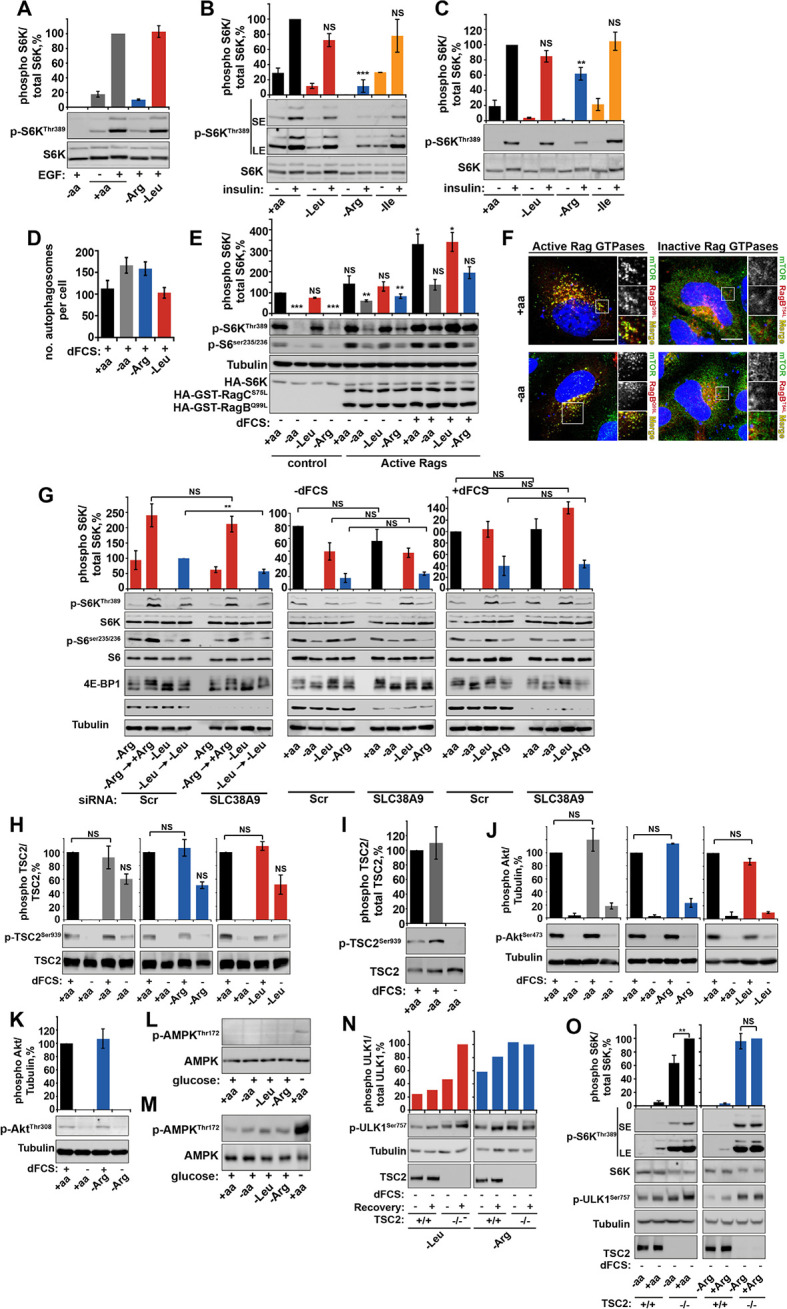
Arginine contributes to mTORC1 activity via TSC2/Rheb signaling axis.(A–C) Arginine deprivation specifically perturbs growth factor-mediated mTORC1 activity. HeLa cells (A, B) and wild-type MEFs (C) were incubated with either a complete amino acid mixture or starved of individual amino acids as indicated, in the presence or absence of EGF (100 ng/ml) (A) or insulin (10 μg/ml) (B, C). Lysates were subjected to immunoblotting for phosphorylation of S6K. (D) Arginine starvation activates autophagy. HeLa cells were pre-treated with chloroquine for 3 hr prior to being starved of the indicated amino acid (in the presence of dFCS) for 1 hr. Cells were fixed and stained with antibodies against LC3. The number of autophagosomes per cell was quantified. (E–G) Perturbation of growth factor signaling by arginine starvation is not dependent on SLC38A9/Rag GTPase protein complexes. HeLa cells were transfected with constitutive active heterodimer of RagB (Q99L), RagC (S75L), and HA-tagged S6K and deprived of amino acids as indicated, either in the presence or in the absence of dFCS. Lysates were analyzed by immunoblot for phosphorylation of S6K (E). (F) HeLa cells were transfected with active or inactive Rag GTPases and incubated in the presence or absence of amino acids. Cells were fixed and stained with antibodies against mTOR and V5 or HA-tagged Rag GTPases to confirm their localization and effect on mTOR localization. (G) HeLa cells were subjected to siRNA against SLC38A9 (100 nM) or scramble control (Scr) for 96 hr. Cells were then analyzed for mTORC1 activity in cells; first, cells were starved and recovered with either arginine or leucine or starved either in the presence or absence of dFCS. Cell lysates were analyzed for phospho-S6K, phospho-S6 and 4E-BP1 and SLC38A9. HeLa cells (H) and wild-type MEFs (I) were incubated with amino acid and dFCS mixtures as indicated. Lysates were analyzed for phosphorylation of TSC2 at serine 939. Of note, there is some increased phosphorylation in cells completely starved of amino acids, arginine and leucine. It has been noted previously that amino acid deprivation can contribute to feed-back mechanisms that involve IRS1 and re-activation of Akt (see review [Manning, 2004]). As there was no specificity to arginine starvation, this observation was not explored further. HeLa cells (J, K) were incubated with amino acid and dFCS mixtures as indicated. Lysates were analyzed for phosphorylation of Akt at serine 473 (J) or threonine 308 (K). HeLa cells (L) and wild-type MEFs (M) were incubated with amino acid and dFCS mixtures as indicated. Lysates were analyzed for phosphorylation of AMPK. As a positive control, cells were starved of glucose. (N, O) Loss of TSC2 renders mTORC1 insensitive to arginine deprivation. TSC2+/+ and TSC2-/- MEFs were subjected to leucine or arginine starvation. Where indicated, recovery was carried out by the re-addition of arginine or leucine. Lysates were assessed for phosphorylation of ULK1 by immunoblotting (N). Alternatively, TSC2+/+ and TSC2-/- MEFs were subjected to amino acid or arginine starvation. Lysates were analyzed for phosphorylation of S6K and ULK1 (O). Scale bars: 10 μm. Nuclei are visualized in merge images with TO-PRO-3 iodide. All graphs with statistics represent an average of at least three independent experiments and error bars represent s.e.m. Graphs not displaying statistics represent an average of two independent experiments and error bars represent standard deviation. *p<0.05, **p<0.01, ***p<0.005. SE: short exposure; LE: long exposure; NS: not significant.